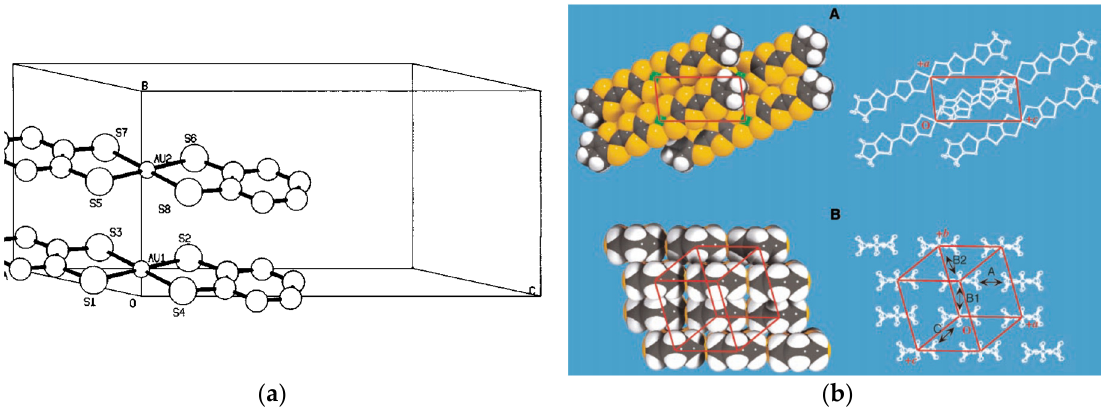
Figure 9. Crystal structures of single component molecular materials: ( a ) A 1D soft Mott insulator, Au(bdt) 2 (bdt = benzene- 1,2-dithiolate); ( b ) A 3D metallic conductor, Ni(tmdt) 2 (tmdt = trimethylenetetrathiafulvalenedithiolate), viewed along ( A ) the b axis and ( B ) the long molecular axis. A, B1, B2, and C denote intermolecular interactions responsible for conductivity. Reproduced from ( a ) Ref. [829] and ( b ) Ref. [831] with permission.